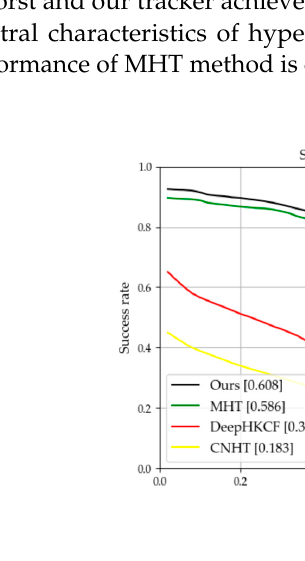
Figure 7. Comparison of hyperspectral trackers. ( a ) Precision plots of different hyperspectral trackers; ( b ) Success plots of different hyperspectral trackers.